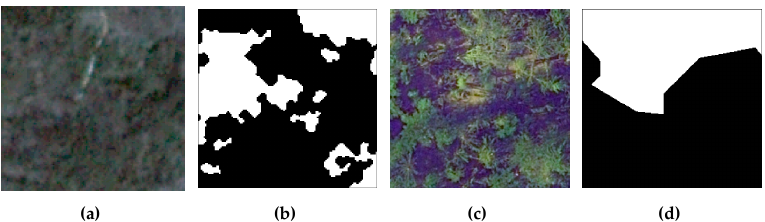
Figure 4. Image and label tiles for satellite ( a , b ) and aerial image ( c , d ) data. White represents damaged, black not damaged. For scale: 256 × 256 pixels with 3 m ( a , b ) and 0.2 m ( c , d ) spatial resolution.